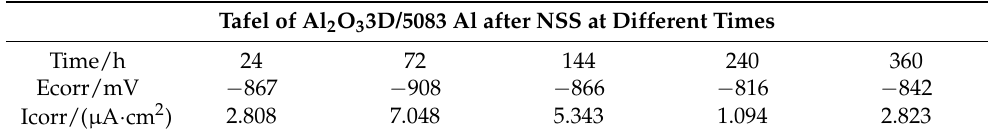
Table 4. Tafel of Al 2 O 3 3D/5083 Al after NSS at different time. Tafel of Al 2 O 3 3D/5083 Al after NSS at Different